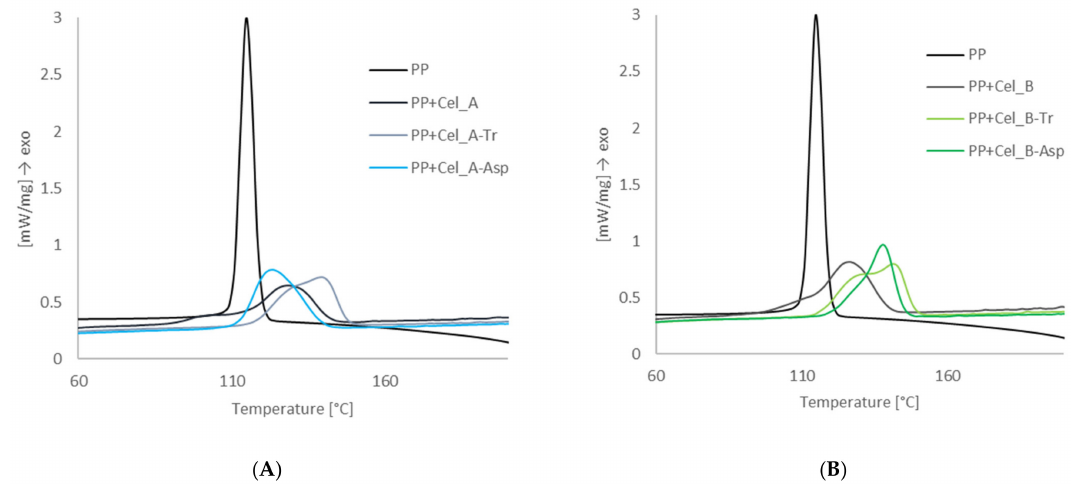
Figure 7. Thermograms of the crystallization process for polypropylene matrix and composite materials with cellulose Cel_A ( A ) and cellulose Cel_B ( B ) before and after